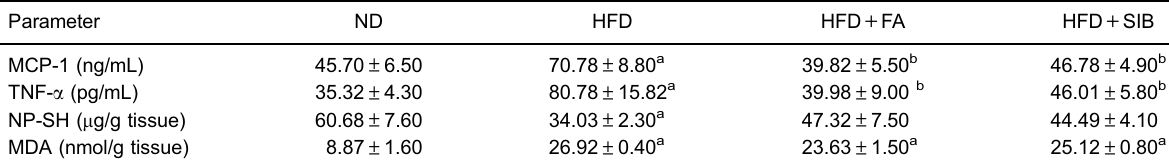
Table 3. Effects of ferulic acid (FA) sibutramine (SIB) treatments on blood levels of monocyte chemotactic protein-1 (MCP-1), TNF- a , and the hepatic tissue levels of non-protein sulfhydrils (NP-SH), and malondialdehyde (MDA), in mice fed experimental diets for 15 weeks.